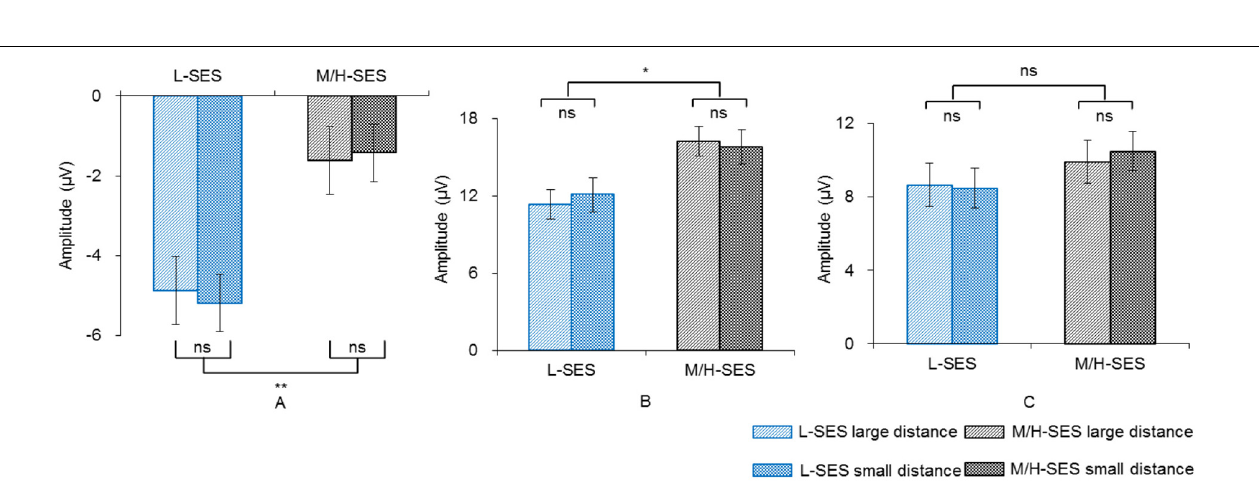
FIGURE 3 | The average amplitudes of the children with different SES in different conditions for three time windows. (A) 100–140 ms, (B) 200–250 ms, (C) 450–700 ms; ns, no significance, * p < 0.05, ** p < 0.01. L-SES, low SES; M/H-SES, middle/high